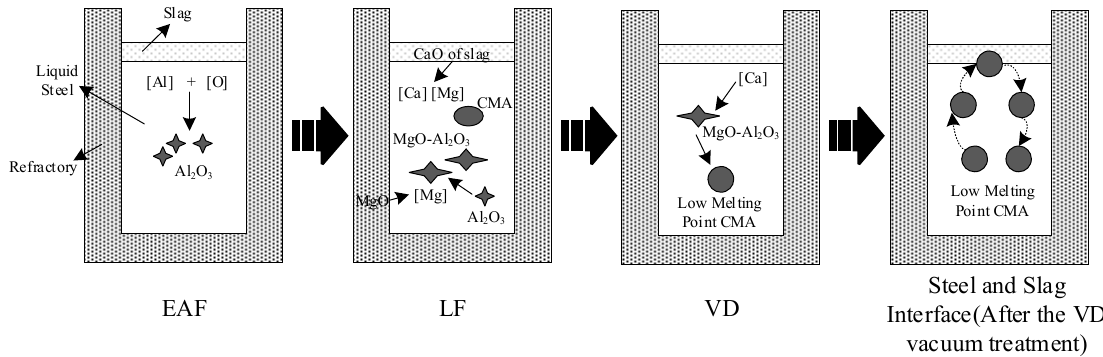
Figure 15. Schematic of inclusion formation and removal mechanism.